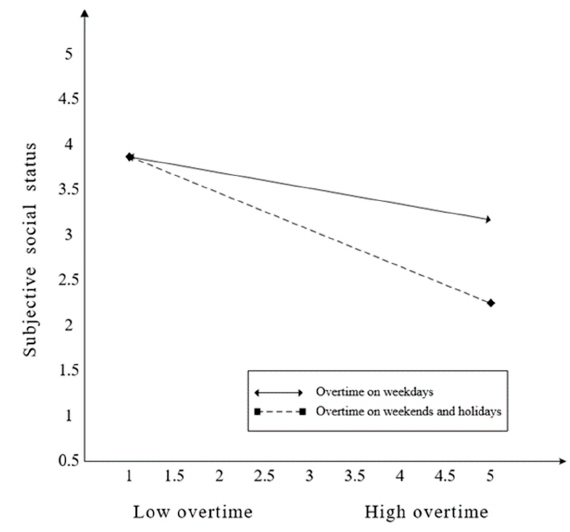
Figure 2. The moderating effect of time type between overtime and subjective social status.